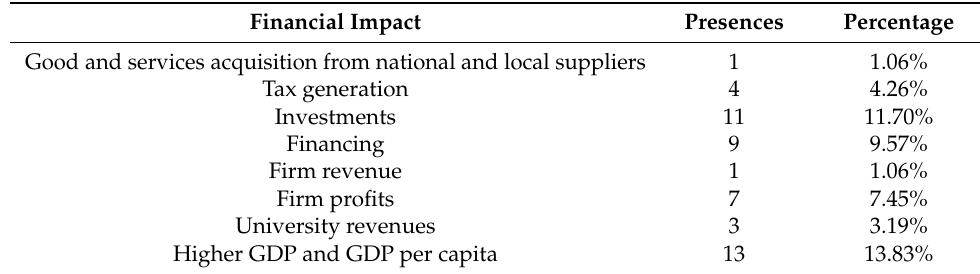
Table A6. Financial impacts of university–industry